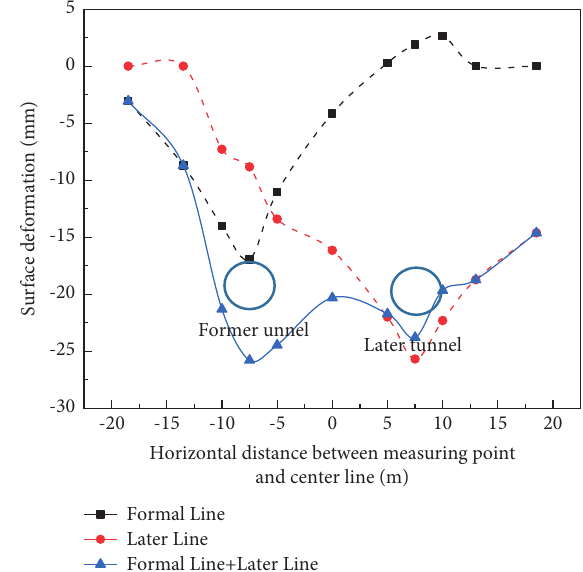
Figure 3: Surface deformation of section DBC10.